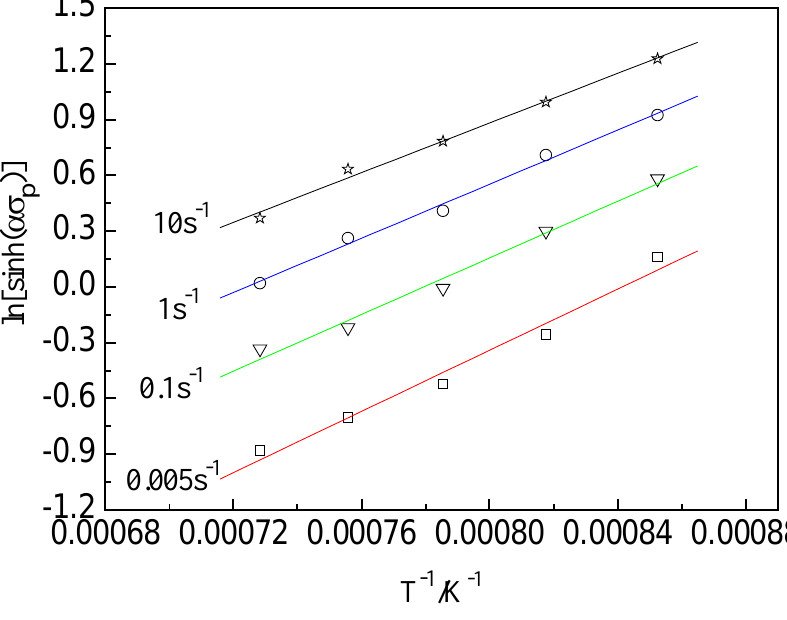
Figure 4. Relation between ln[sinh( ασ p )] and 1/ T at different strain rate.